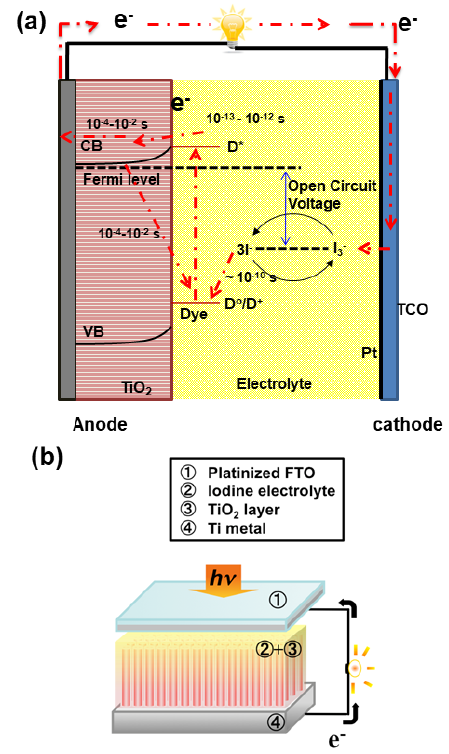
Figure 9. Schematic diagram of a dye-sensitized solar cell (DSSC): ( a ) Principle of a dye-sensitized solar cell and the time scales of various processes; ( b ) a full cell constructed with anodic TiO 2 nanotubes. Reproduced with permission from reference [8]. American Chemical Society (2014).